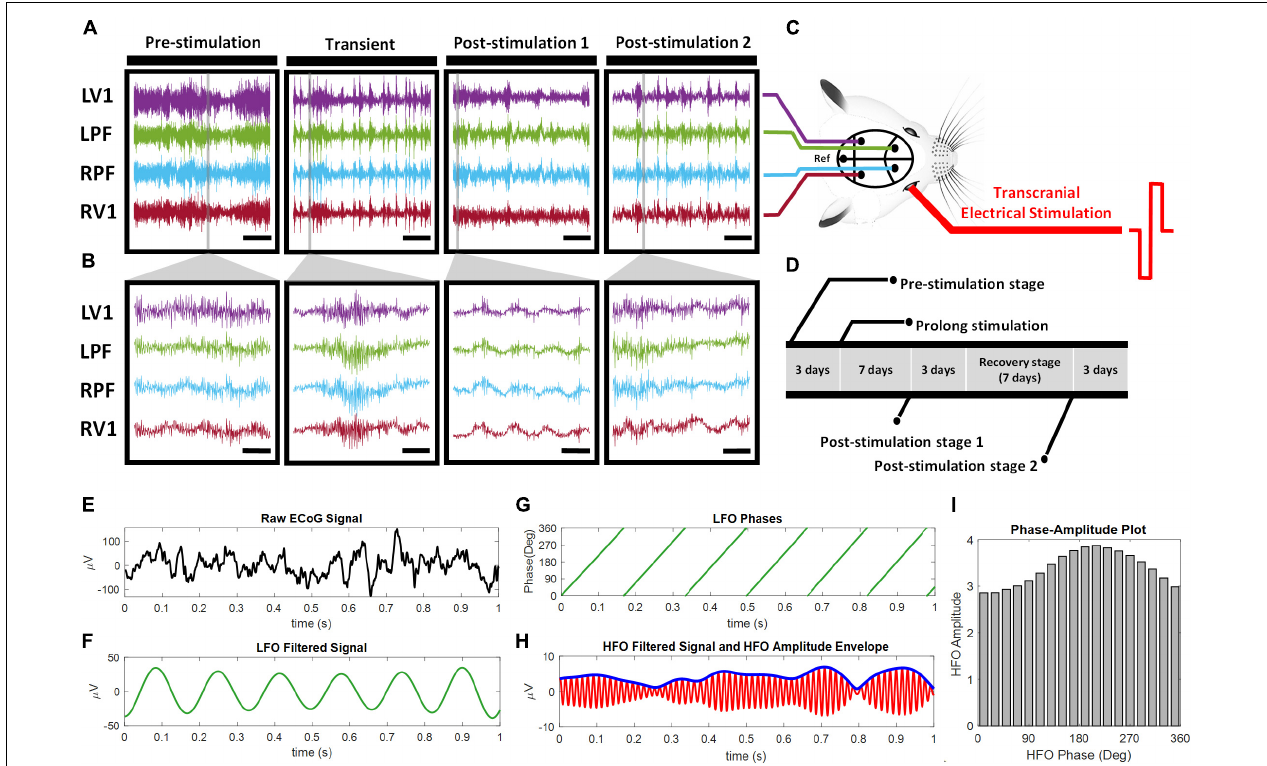
FIGURE 1 | ECoG Experimental design and steps taken to compute cross-frequency phase-amplitude coupling. (A,B) Represent ECoG signal traces from one rd10 mouse. ECoG signal was recorded from the four brain sites: the left primary visual cortex (LV1), the left prefrontal cortex (LPF), the right prefrontal cortex (RPF) and the right primary visual cortex (RV1) across four stages of stimulation (pre-stimulation, transient, post-stimulation 1 and post-stimulation 2) (A) scale bar, 5 s, (B) Scale bar, 100 ms. (C) Pictorial representation of the ECoG recording positions in the mouse brain and biphasic transcorneal electrical stimulation applied to the right eye. Ref: reference electrode position. (D) Timeline of experimental design. Transient stage ECoG recording was performed on the first day of the 7 days prolonged stimulation. The raw ECoG signal (E) was filtered into phase of LFO (F) and amplitude (thin line) of HFO (G) . The time series of LFO phase and amplitude envelope of HFO (thick line) was computed from the respective filtered ECoG signals via Hilbert transformation (H) . The phase amplitude plot (I) was constructed and used to calculate the mean distribution of amplitudes over the phase